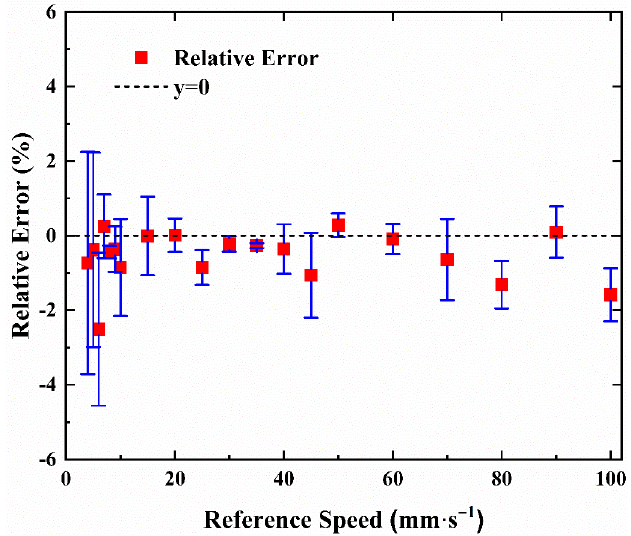
Figure 7. The measured velocity against the reference velocity of the slide rail in the range of 4 mm·s −1 to 100 mm·s −1 (R 2 = 1.00000).